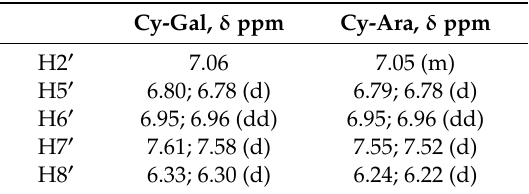
Figure 5. Two-dimensional ( 1 H- 1 H COSY) NMR spectrum for fruit sample LS6 (7-August). Table 2. 1 H-NMR chemical shifts ( δ , ppm) for cyanidin galactoside (Cy-Gal) and cyanidin arabinoside (Cy-Ara) in